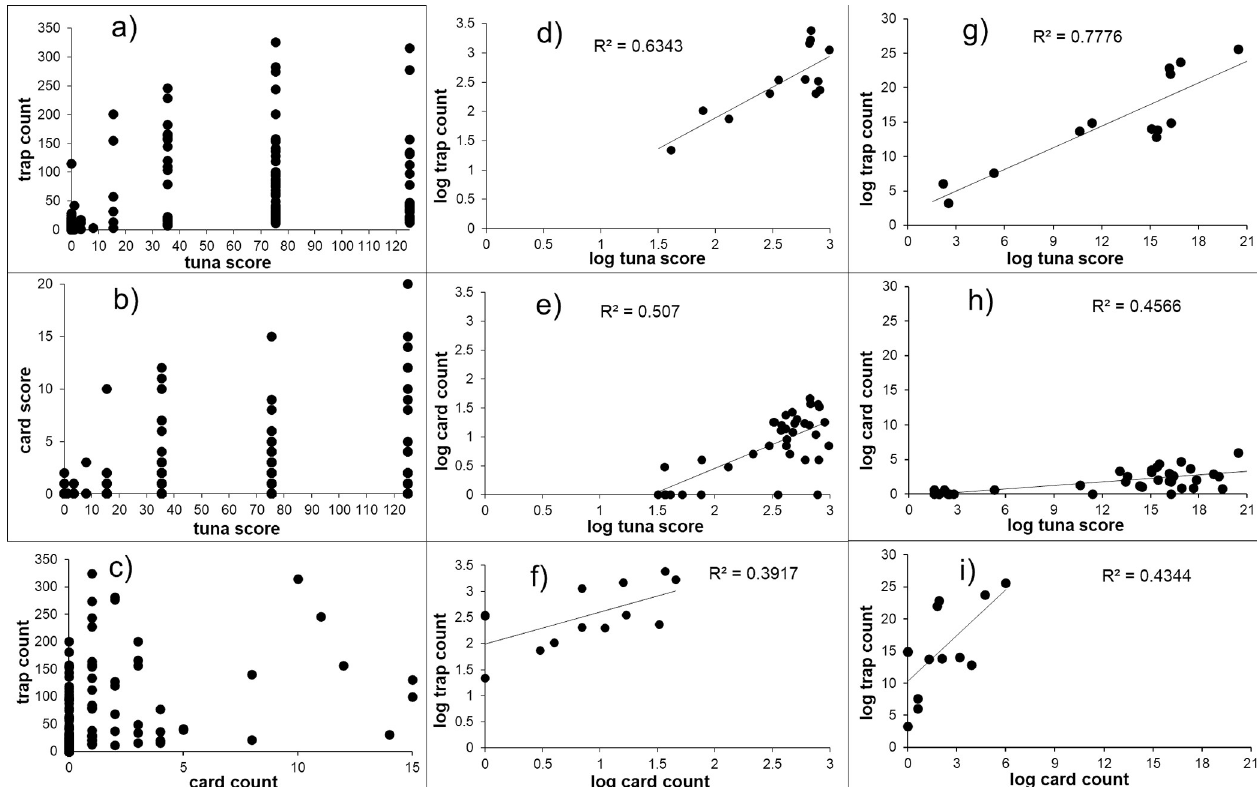
Fig 1. Pairwise relationships of the three sampling methods of card counts, pitfall trapping and tuna lures with raw sample-level data (a-c), transect-level data compiled from first pooling sample-level data then applying a log(x+1) transformation (d-f) and transect-level data compiled by pooling sample-level data that had first undergone a log(x+1) transformation (g-i).